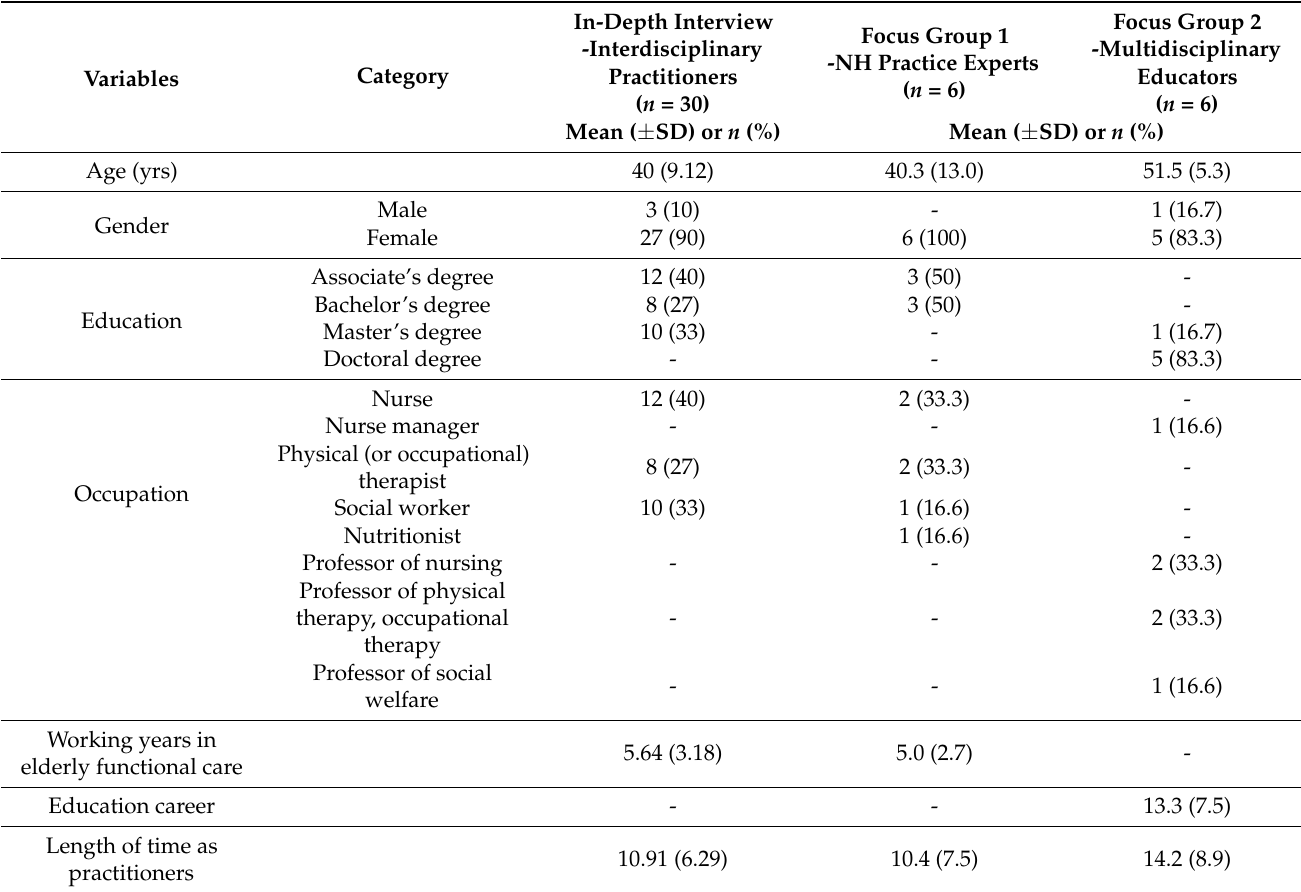
Table 1. Characteristics of the in-depth interview and focus group